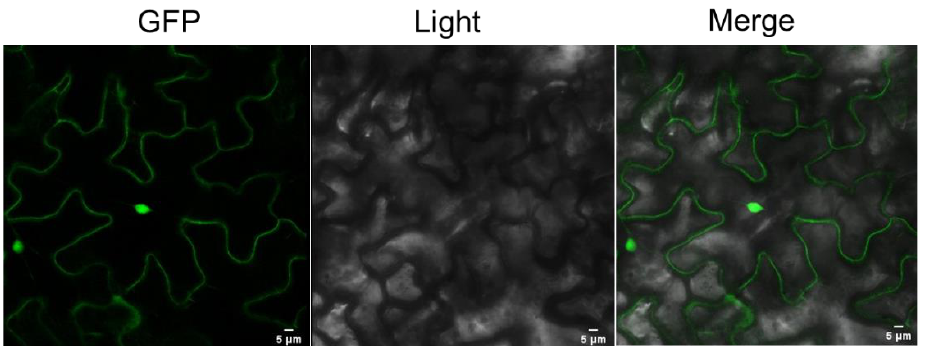
Figure 8. Subcellular localization of HsMT1L. Images were taken by using Leica confocal microscopy. GFP: GFP fluorescence under green light; Light: visible light image; Merge: merge images of the above two images.